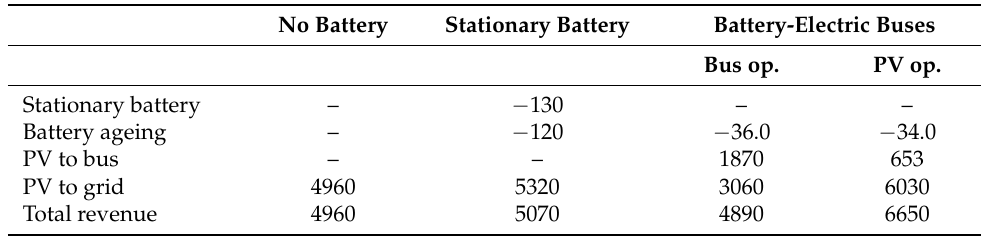
Table 6. Revenue comparison for the PV operator considering no storage, stationary batteries (1% of the installed PV capacity i.e., 13.5kWh), and BEBs (in SGD) for a ramp rate limit of 1%. The ramping costs are not deducted from the total revenue, as they are implicitly included in the lower revenue for PV to battery, bus, or grid for one week. No Battery Stationary Battery Battery-Electric Buses Bus op. PV